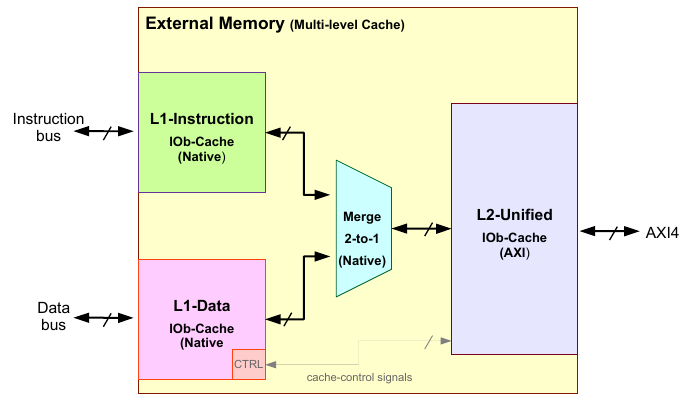
Figure 11. External Memory: two-level cache system